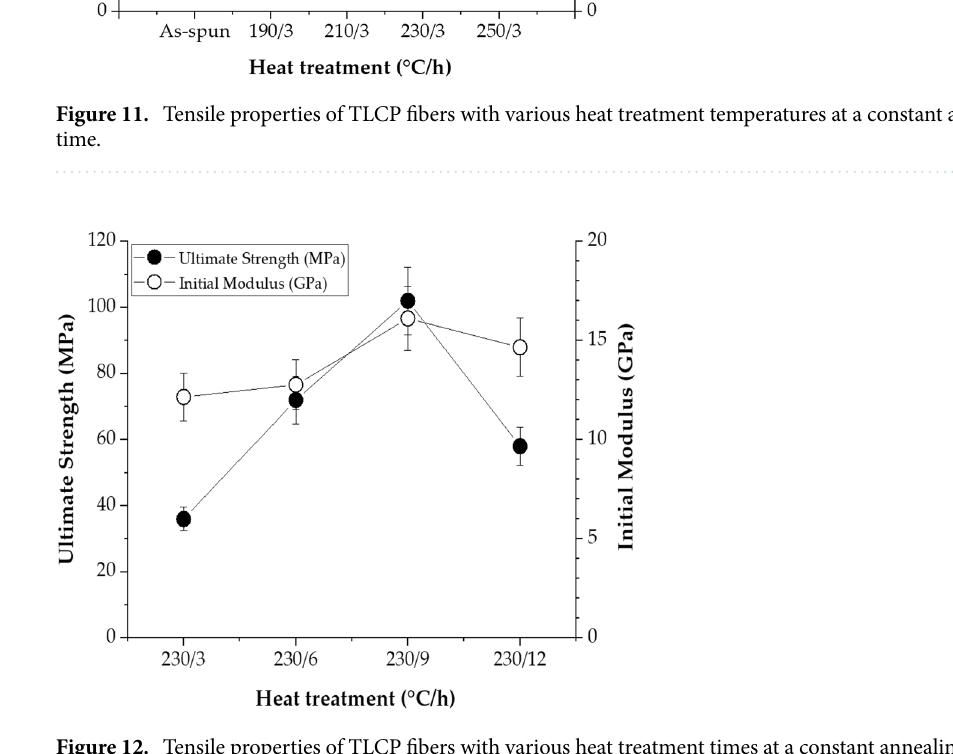
Figure 12. Tensile properties of TLCP fibers with various heat treatment times at a constant annealing